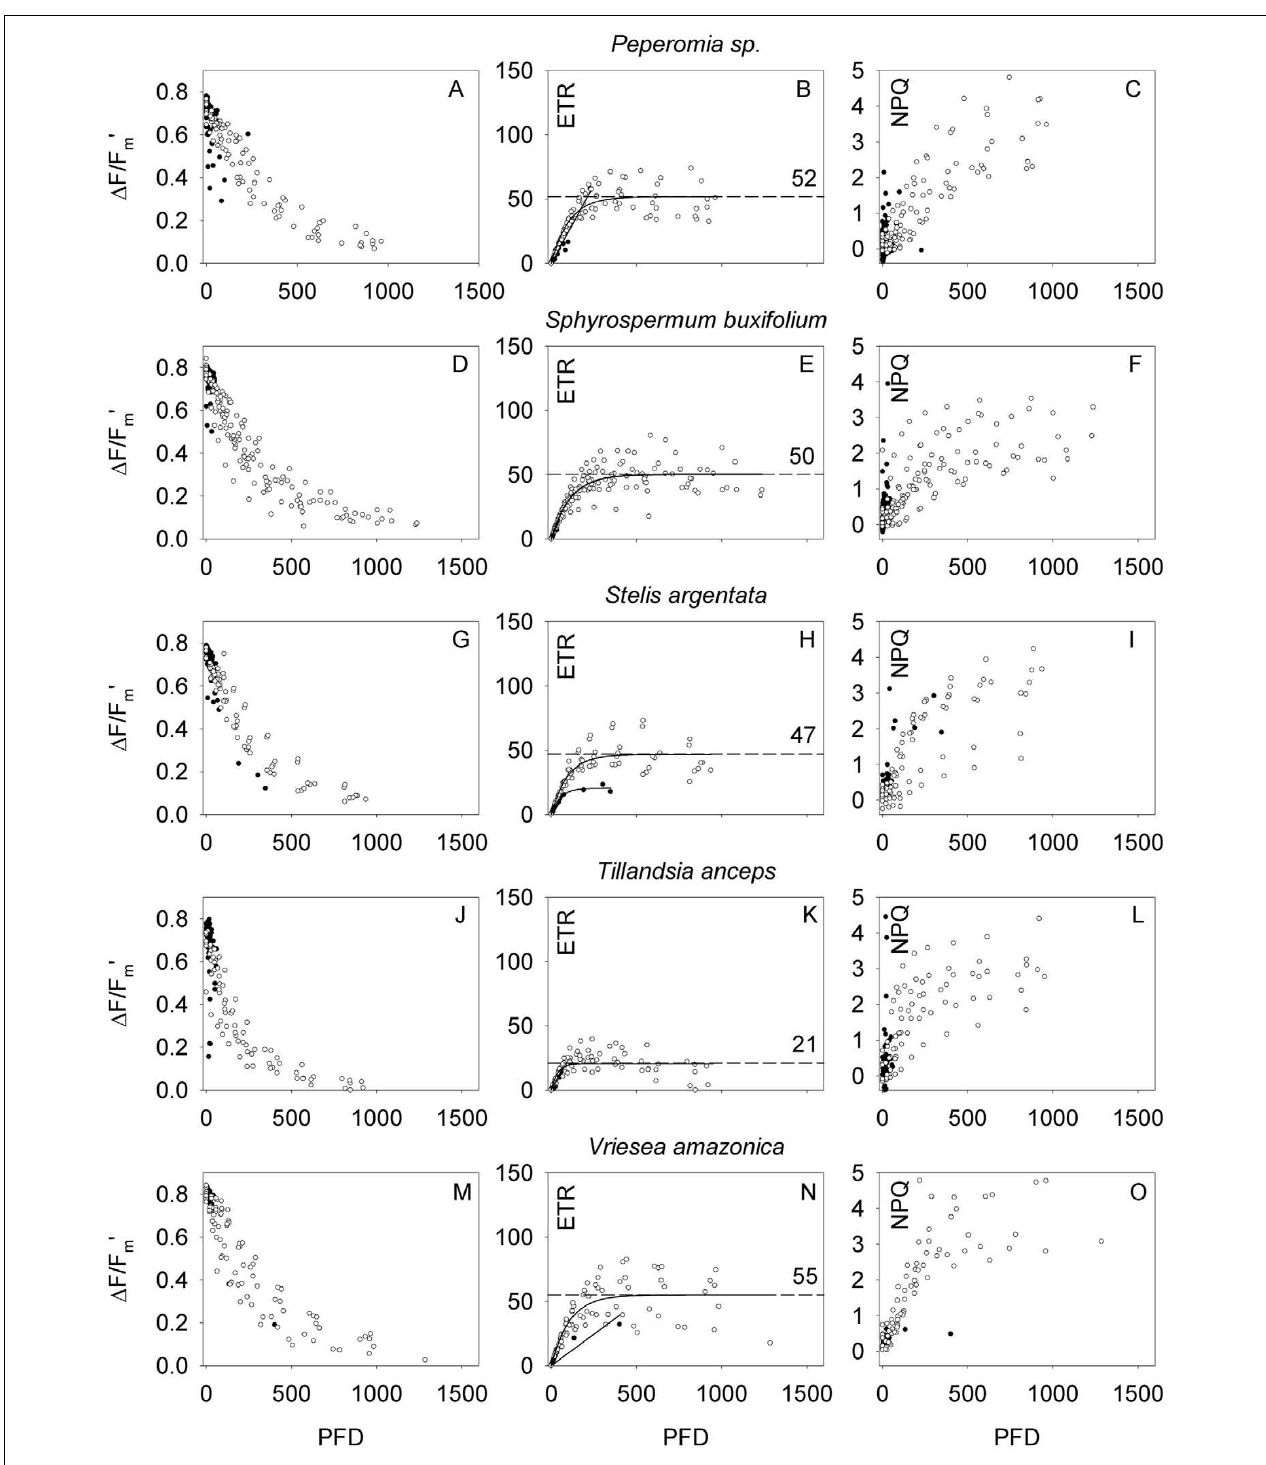
bromeliad Vriesea amazonica (M–O). Closed symbols refer to measurements under ambient PFD, while open symbols refer to instant light response curves with an adaptation time of 30s. ETR values were fitted using a single exponential function, the resulting best fitted function is shown in the graphs (solid lines: ETR max from ambient measurements, dashed lines, and numbers: ETR max from instant light response curves; ETR is given in micromole electrons m − 2 s − 1